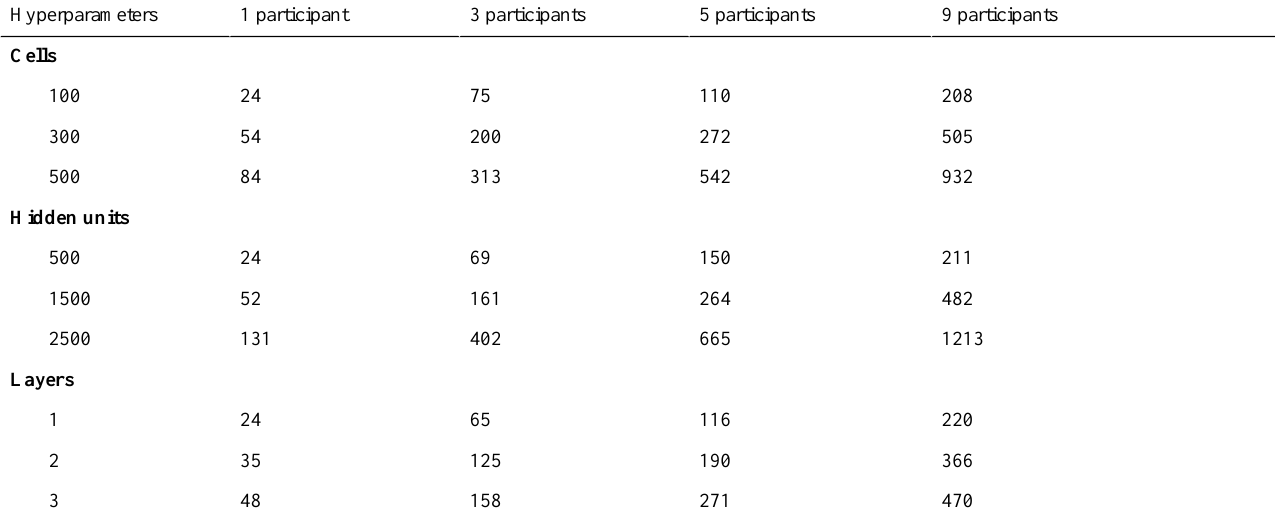
Table 2. Training time (minutes) for the hyperparameter